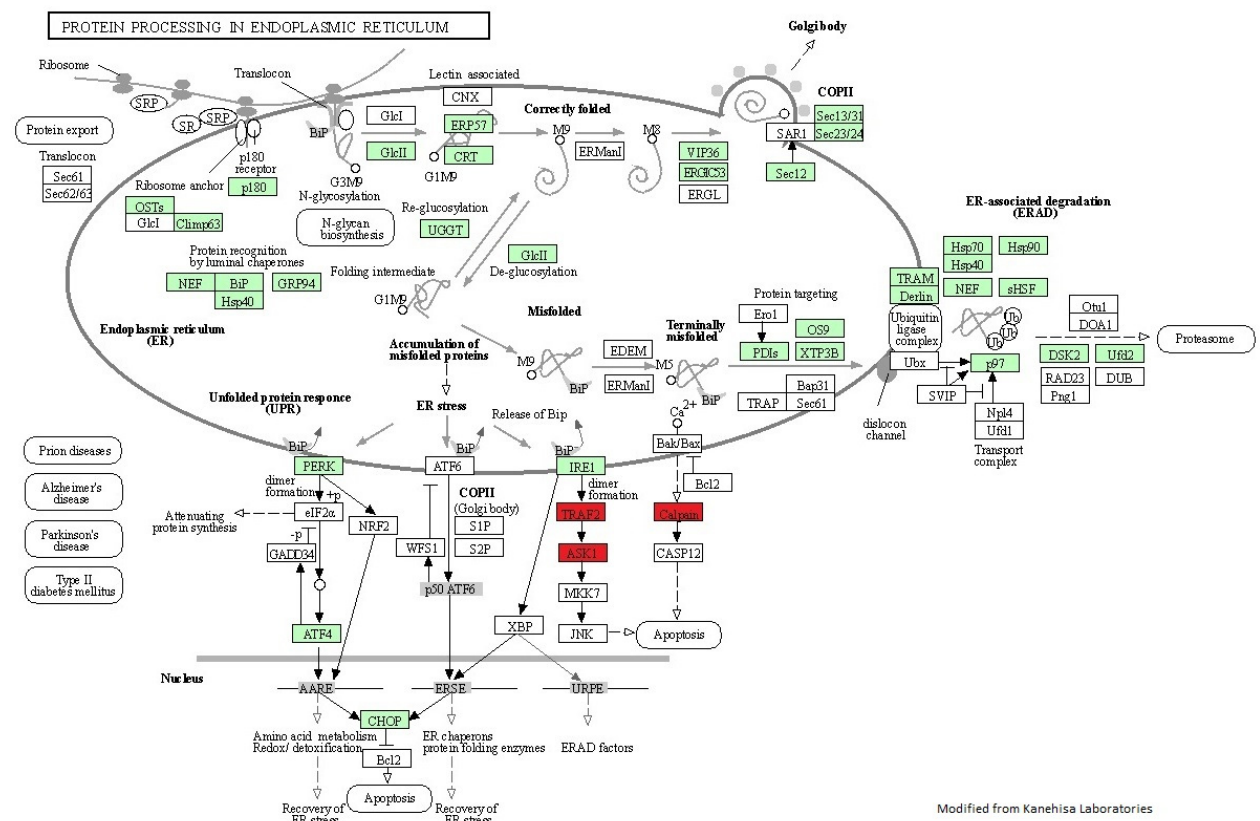
Figure 4. Illustration of transcriptional changes in liver of G. chilensis in response to high-temperature stress using modified KEGG pathway map of protein processing in the endoplasmic reticulum. The red rectangles indicate down-regulated transcripts, while green rectangles indicates up-regulated transcripts between the control and high-temperature groups.